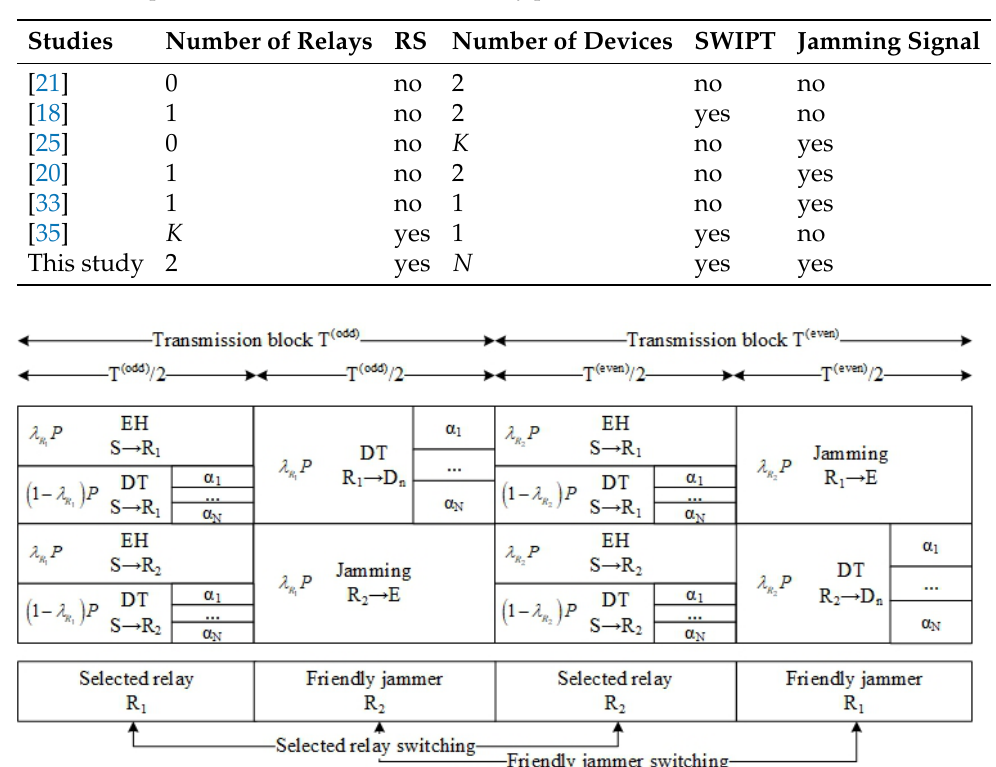
Figure 1. The green-cooperative IoT wireless network. Table 1. Comparison to the other studies on secrecy performance.